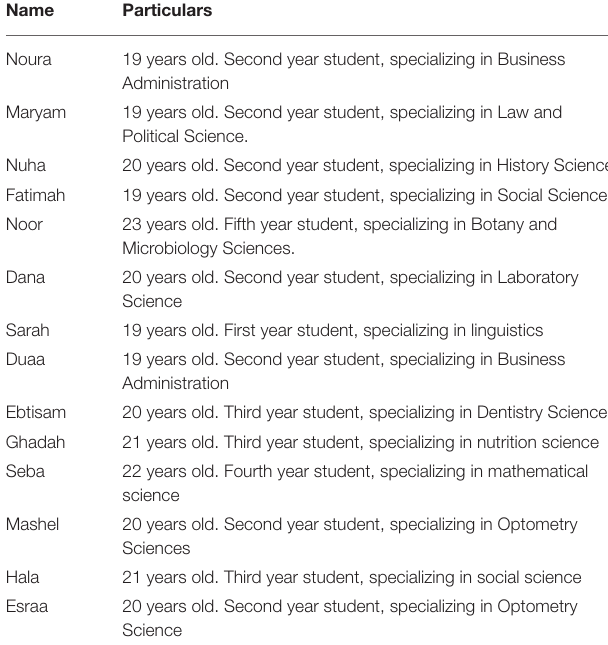
TABLE 1 | Brief background on KSU students who were